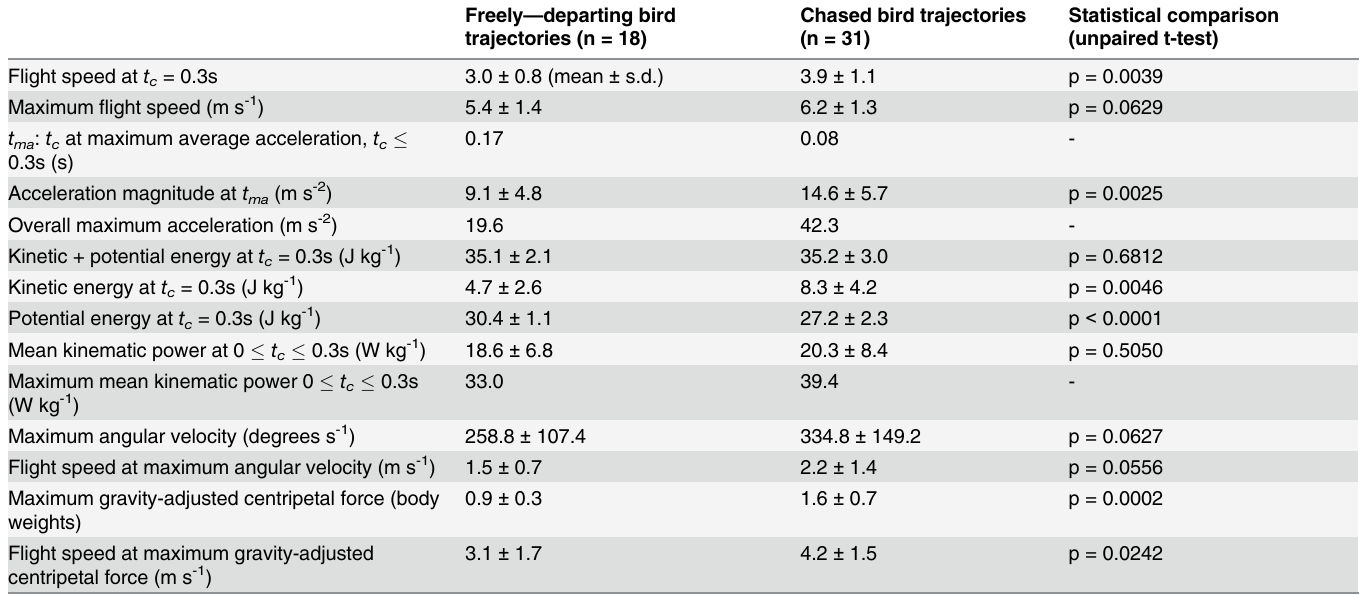
Table 1. Departing bird